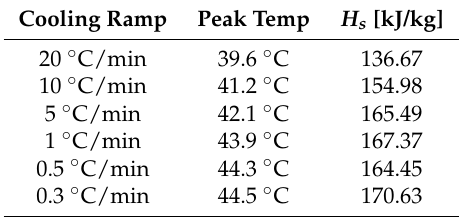
Figure 14. ( a ) Behavior of a PCM after heating and cooling process; ( b ) Enthalpy-temperature curve for the experimental PCM RT45 in cooling process. Table 7. Experimental DSC results in range given by